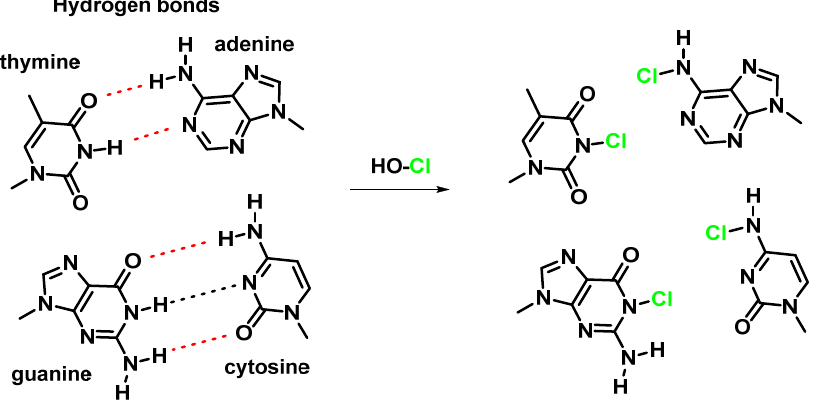
28 of 46 Figure 44. ( a ) Faster NH-chlorination of thymidine, uridine, inosine, and guanosine; and ( b ) slower –NH 2 chlorination of adenosine, cytidine, and guanosine. Experiments with nucleoside mixtures show that the propensity for radical for- mation is cytidine > adenosine = guanosine > uridine = thymidine heterocyclic chloramines are themselves reactive and capable of acting as chlorine donors. Therefore, these prod- ucts are not suitable biomarkers. However, the C5-chlorination of cytosine has recently been described for deoxycytidine and nucleic acids exposed to myeloperoxidase. 5-chlo- rocytosine appears to be a stable, albeit minority, end product, particularly at near-neutral pH. However, with suitably sensitive detection methods, 5-chlorocytosine may also prove useful as a biomarker for HOCl. Both amino functions are involved in base pairing, so it is not surprising that HOCl − induced base chlorination leads to efficient DNA denaturation. Another example of this is found in NADH where it is observed that, in the reaction with HOCl, there is a fast primary reaction and a slow secondary reaction, when there is excess HOCl, probably in this case destroying the nicotinamide ring. The reaction between HOCl with DNA can lead to structural changes, and chemical